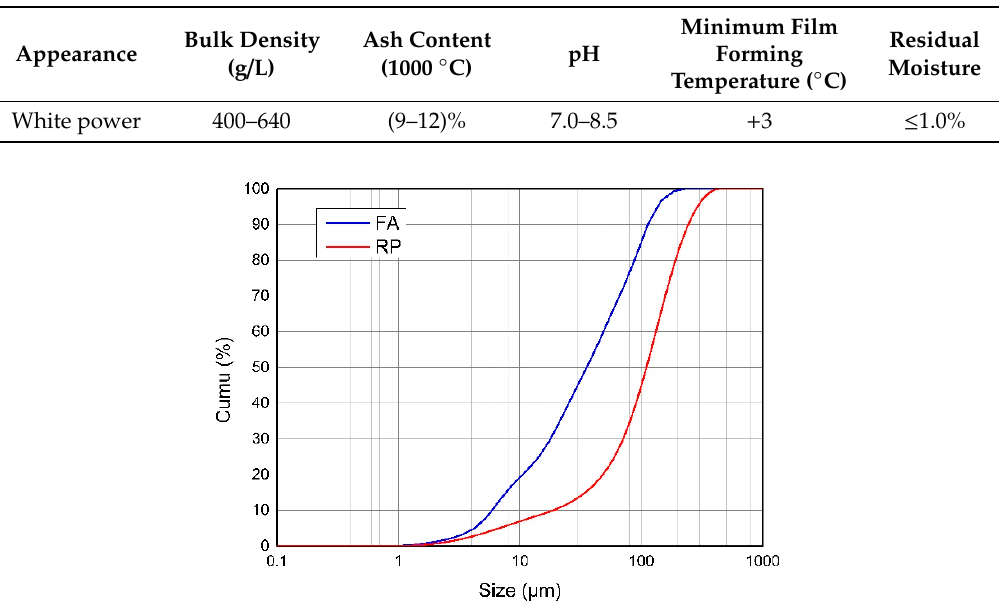
Table 2. Performance parameters of redispersible powder.